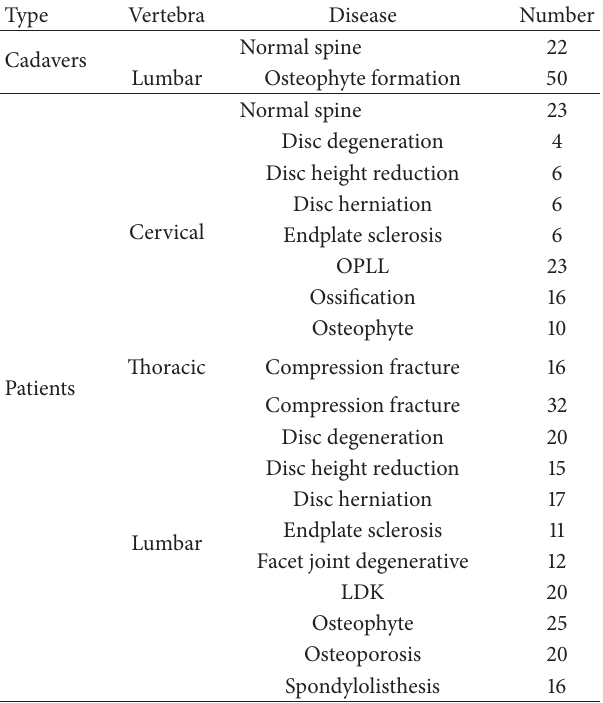
Table 2: The number of cadavers or patients according to degener- ative